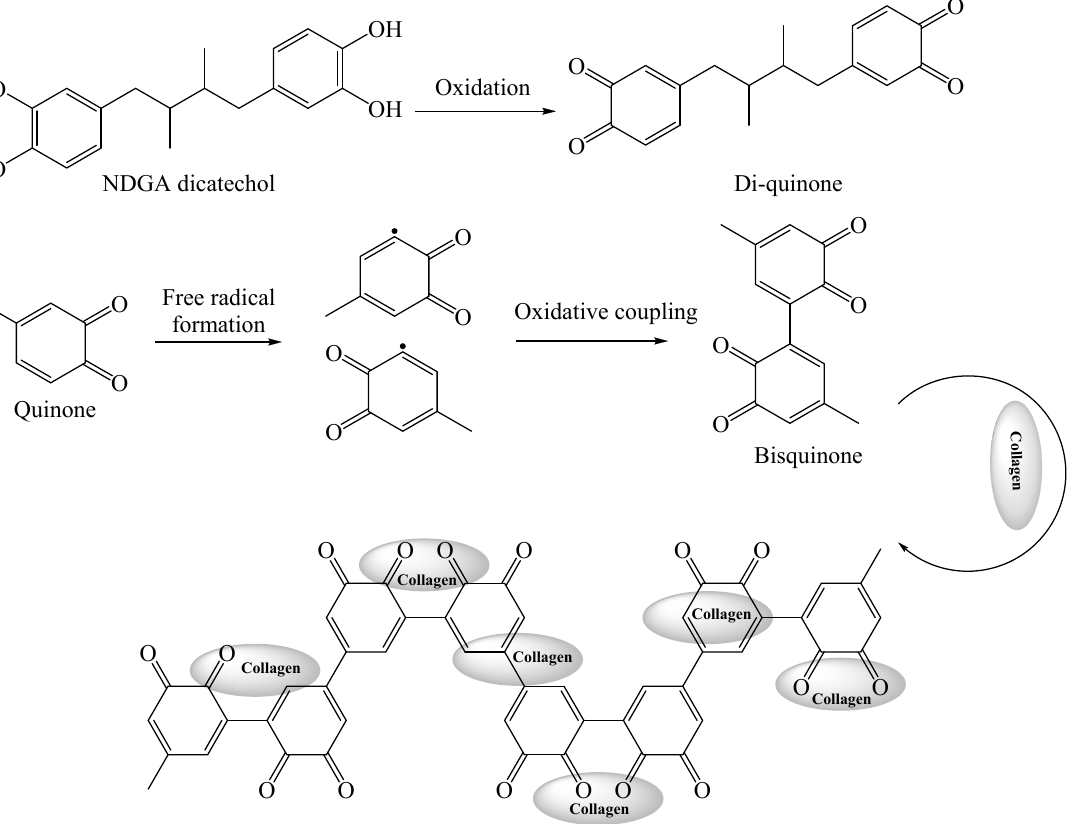
Figure 3. Reaction showing polymerization of nordihydroguairetic acid ‐ bisquinone, initiated by au ‐ tooxidation of the two catechols at neutral/alkaline pH conditions forming quinones, that associated together to form aryloxy free radical resulting in bisquinone crosslinks forming large network of crosslinked bisquinone polymer with collagen fibrils embedded without any crosslinks with amino acid side chains of collagen.